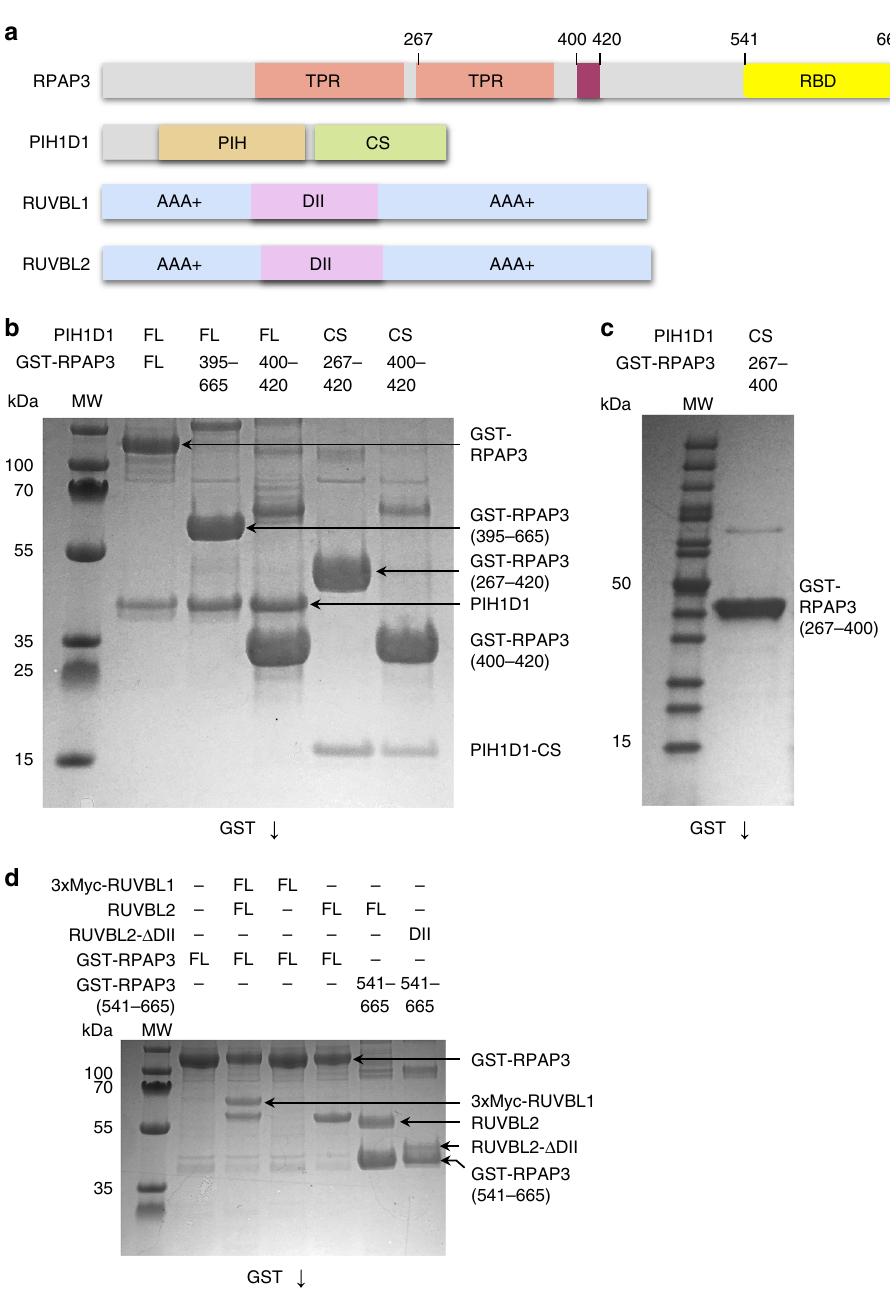
Fig. 1 Mapping the interactions in human R2TP core components. a A cartoon for sequence and domains of the components of the human R2TP complex. b GST pull-down experiments depicting the interactions between the several regions in RPAP3 and PIH1D1. FL stands for full length, CS for the CS domain in PIH1D1, and MW for molecular weight markers. Be aware that for simpli fi cation, several PIH1D1 and RPAP3 constructs are indicated within the same lines on top of the gel. Some minor contaminants are present in some of the samples. c Pull-down experiments showing that removal of residues 401 – 420 from an RPAP3 construct eliminates the interaction with the CS domain in PIH1D1. d Pull-down experiments demonstrating the interaction of RPAP3 – RBD with RUVBL2. This interaction is not affected when the DII domains in RUVBL2 are